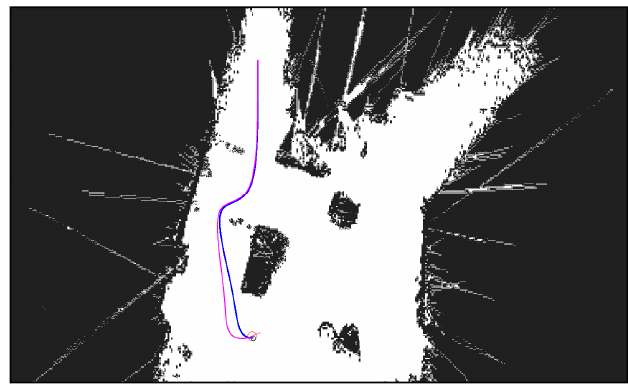
Figure 7. Cumulative errors of actual robot position respect to reference trajectory.